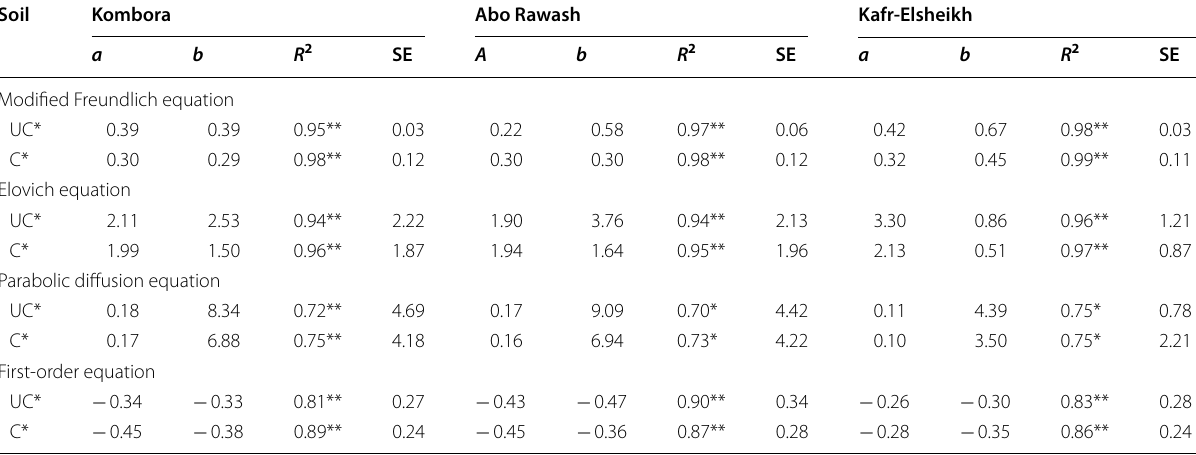
UC uncultivated soil, C cultivated soil